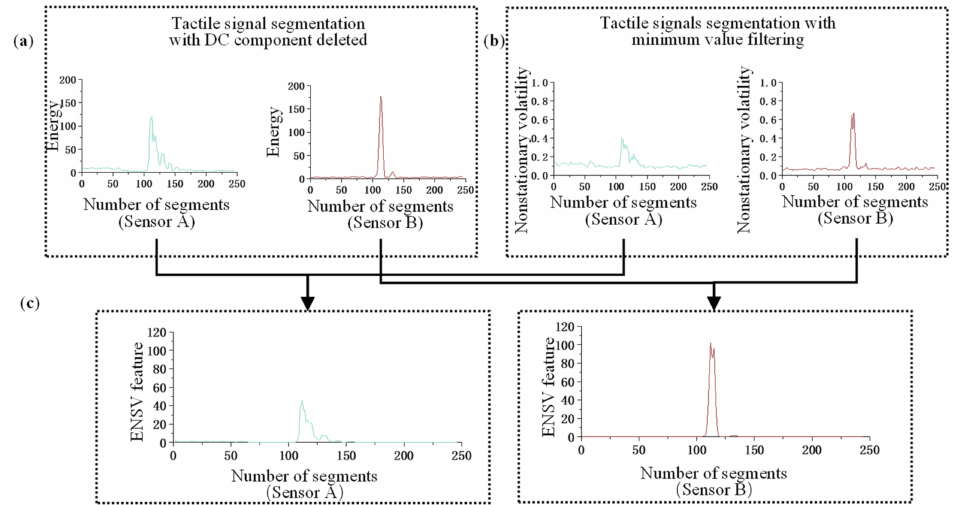
Figure 4. Feature extraction process diagram. ( a ) The result of the energy features of each segment; ( b ) the result of the nonstationary degree of fluctuation of each segment; ( c ) the result of feature